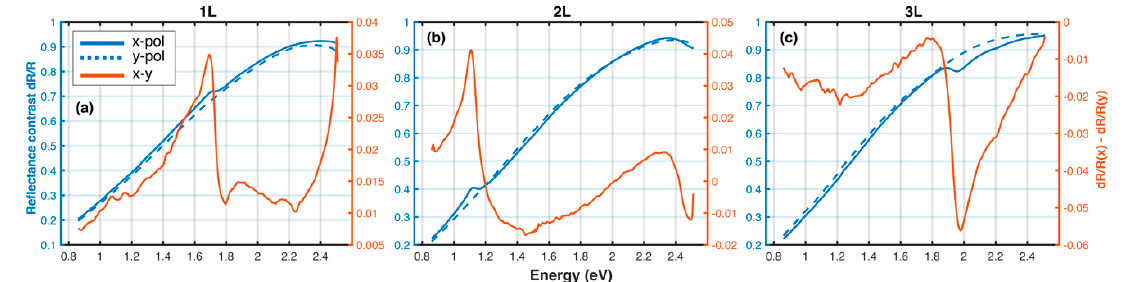
Figure 4. Reflectance contrast (dR / R) calculated using n,k displayed in Figure 2 between (1L ( a ), 2L ( b ), and 3L ( c ), BP on 90 nm SiO 2 / Si) and 90 nm SiO 2 / Si. Solid blue, dashed blue and solid orange curves correspond to dR / R for the x-polarization, y-polarization excitation conditions and the di ff erence between the two, respectively.